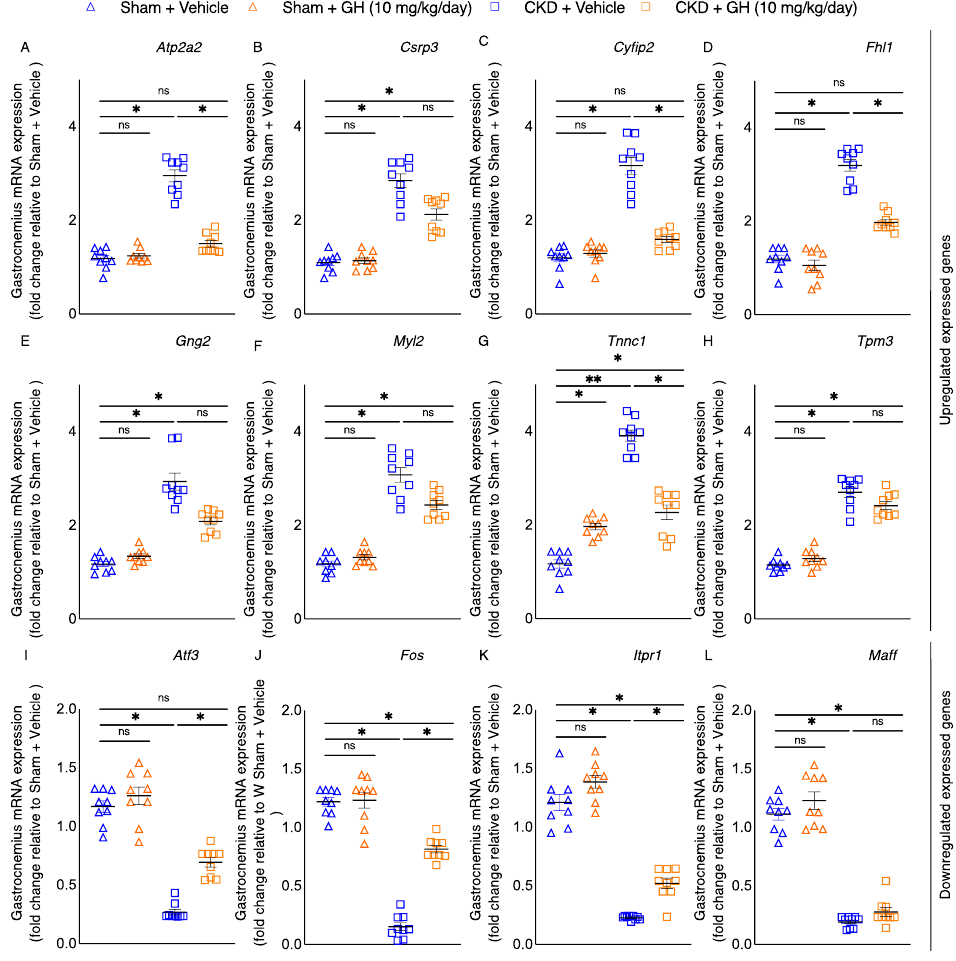
Figure 6. GH reduces the expression of differentially expressed genes in the muscles of CKD mice. CKD mice were fed ad libitum, whereas other mouse groups received an energy intake amount equal to that of CKD + Vehicle mice. The expression of relevant genes in the mouse gastrocnemius muscle was assessed using qPCR ( A – L ). Results are analyzed and expressed as in Figure 2. Data are expressed as mean ± SEM. For comparison of the means between two groups, data were analyzed by Student’s 2 -tailed t -test. Post hoc analysis was performed with Tukey’s test. Specific p -values are shown above the bar. ns signifies not significant, * p < 0.05, ** p < 0.01.